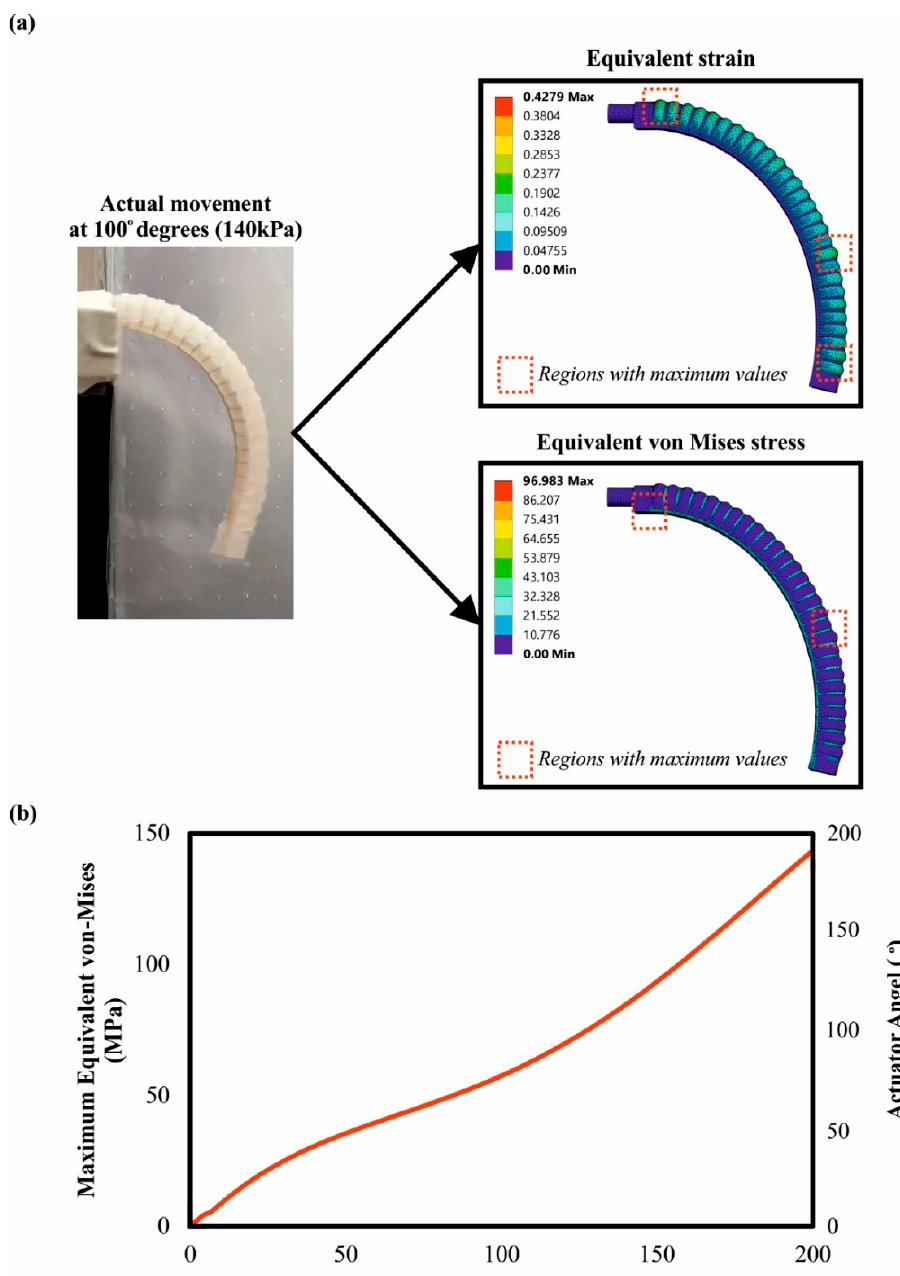
Figure 8. ( a ) Indicative images of the actuator’s motion derived from the physical testing and the FEA; ( b ) Graphical relations between the applied pressure, the bending angle, and the developed von Mises stress on the actuator.